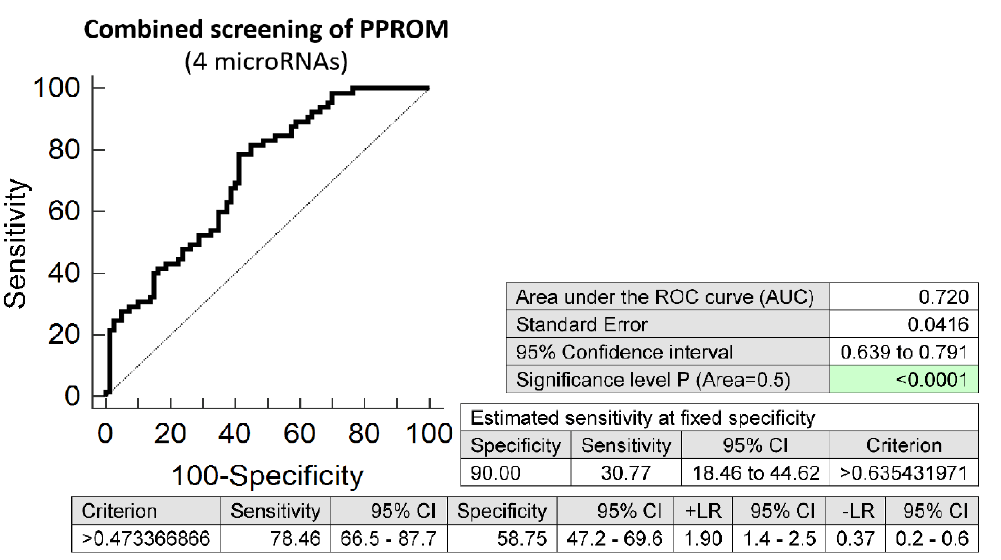
Figure 5. ROC analysis—the best combination of microRNA biomarkers in early prediction of spontaneous preterm birth. The combination of miR-16-5p, miR-20b-5p, miR-24-3p, miR-26a- 5p, miR-92a-3p, miR-133a-3p, miR-146a-5p, miR-210-3p, and miR-342-3p showed that at 10.0% FPR 43.90% PTB pregnancies had aberrant microRNA expression profile in the whole peripheral venous blood in early stages of gestation.